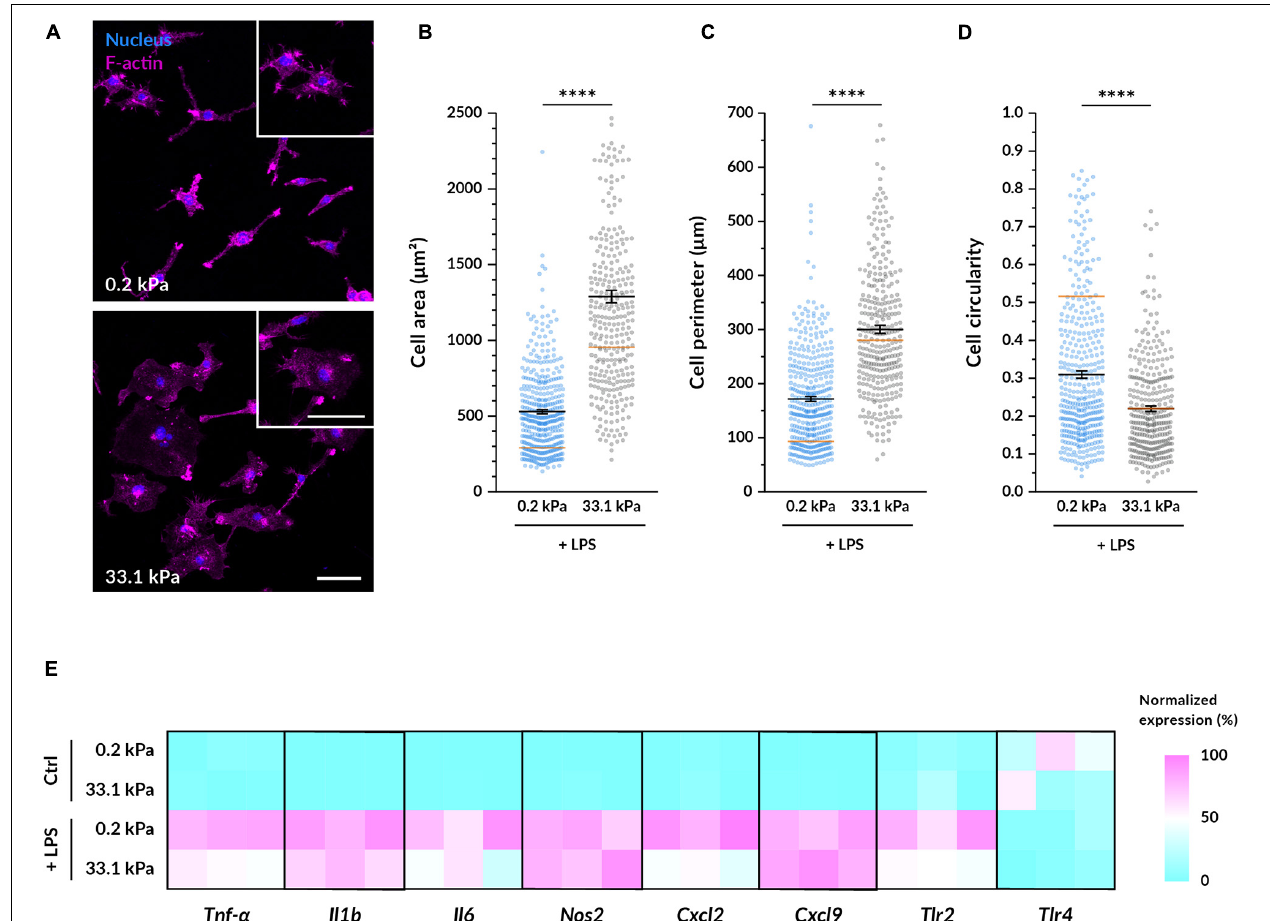
FIGURE 2 | Substrate stiffness influences LPS-primed macrophages. (A) Representative fluorescence microscopy images of BMDMs cultured on the different gels for 14–18 h and then primed with 100 ng/ml LPS for 4.5 h. Nuclei are shown in blue and F-actin in magenta. Enlarged examples of cells of each condition are displayed in the insets. Scale bars, 50 µ m. (B–D) Quantification of the cell area (B) , perimeter (C) , and circularity (D) from images taken under the same conditions as (A) . In all plots, each dot represents a cell, the black bars indicate mean ± SEM, and the reference orange bar indicates the mean of the